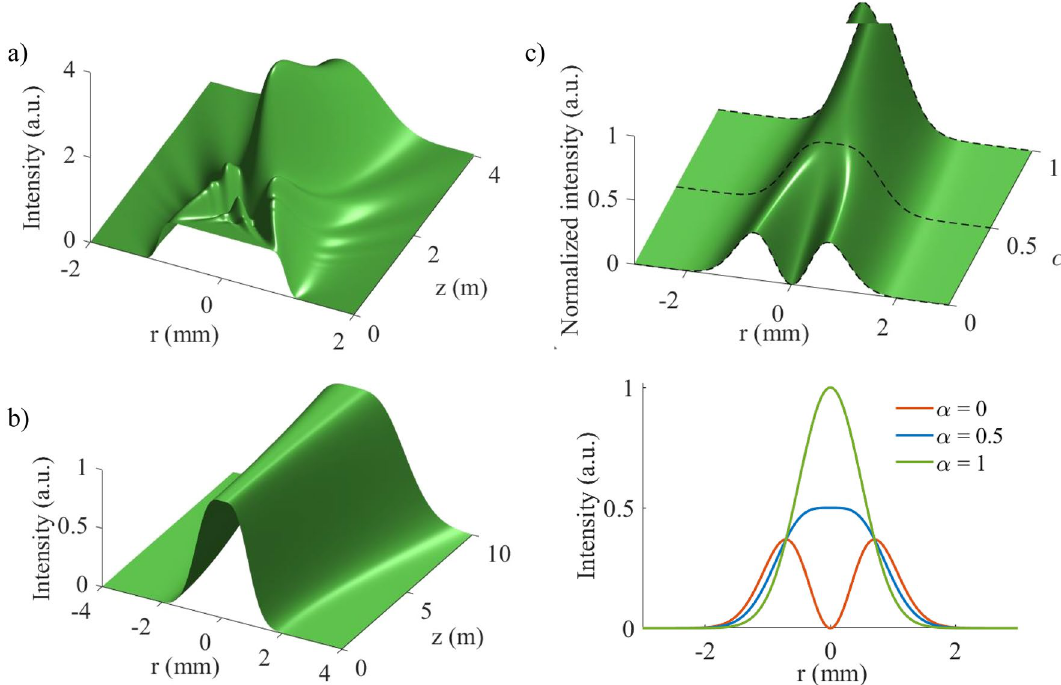
Figure 3. ( a ) Propagation of a scalar flat-top beam simulated using the flattened Gaussian beam approach. ( b ) Propagation of a vector flat-top beam showing the unchanging flat-top profile. The peak intensities were normalized to better visualize the propagation invariance of this beam. ( c ) Intensity profile as α changes showing the evolution from a vortex to a flat-top to a Gaussian beam. The profiles of the vector beam at critical α values are shown in the bottom panel with the vortex beam at α = 0 , the vector flat-top beam at α = 0.5 and the Gaussian beam at α = 1